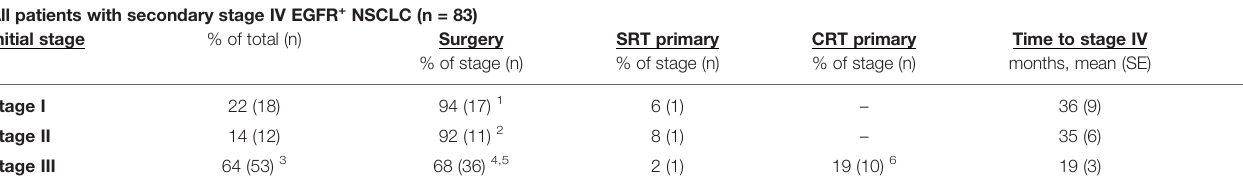
TABLE 2 | Treatment of nonmetastatic EGFR + tumors preceding secondary stage IV disease. All patients with secondary stage IV EGFR + NSCLC (n = 83) Initial